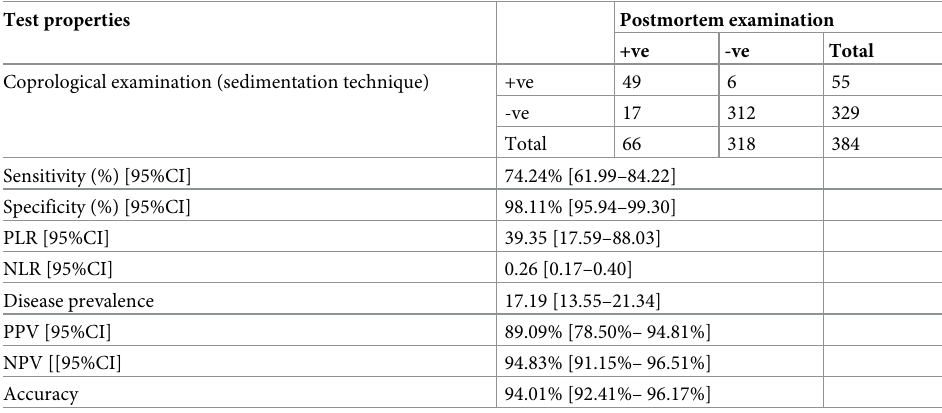
Table 3. Evaluation of the efficacy of sedimentation technique for the diagnosis of bovine schistosomiasis (post- mortem examination as reference